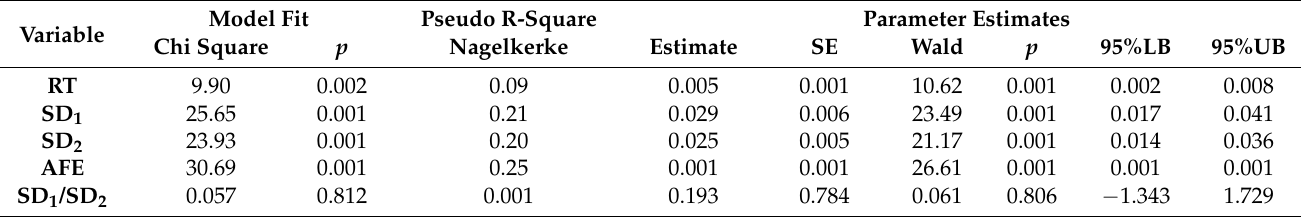
Parameter Estimates